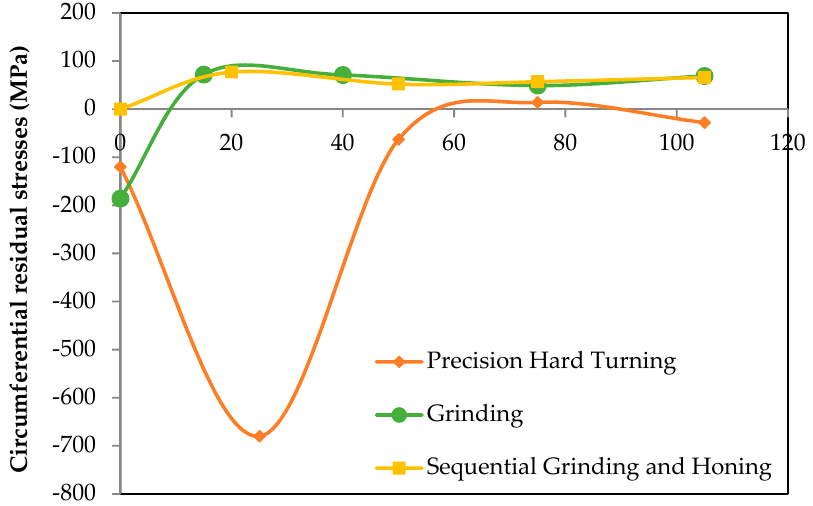
Figure 7. Residual stresses in circumferential direction.